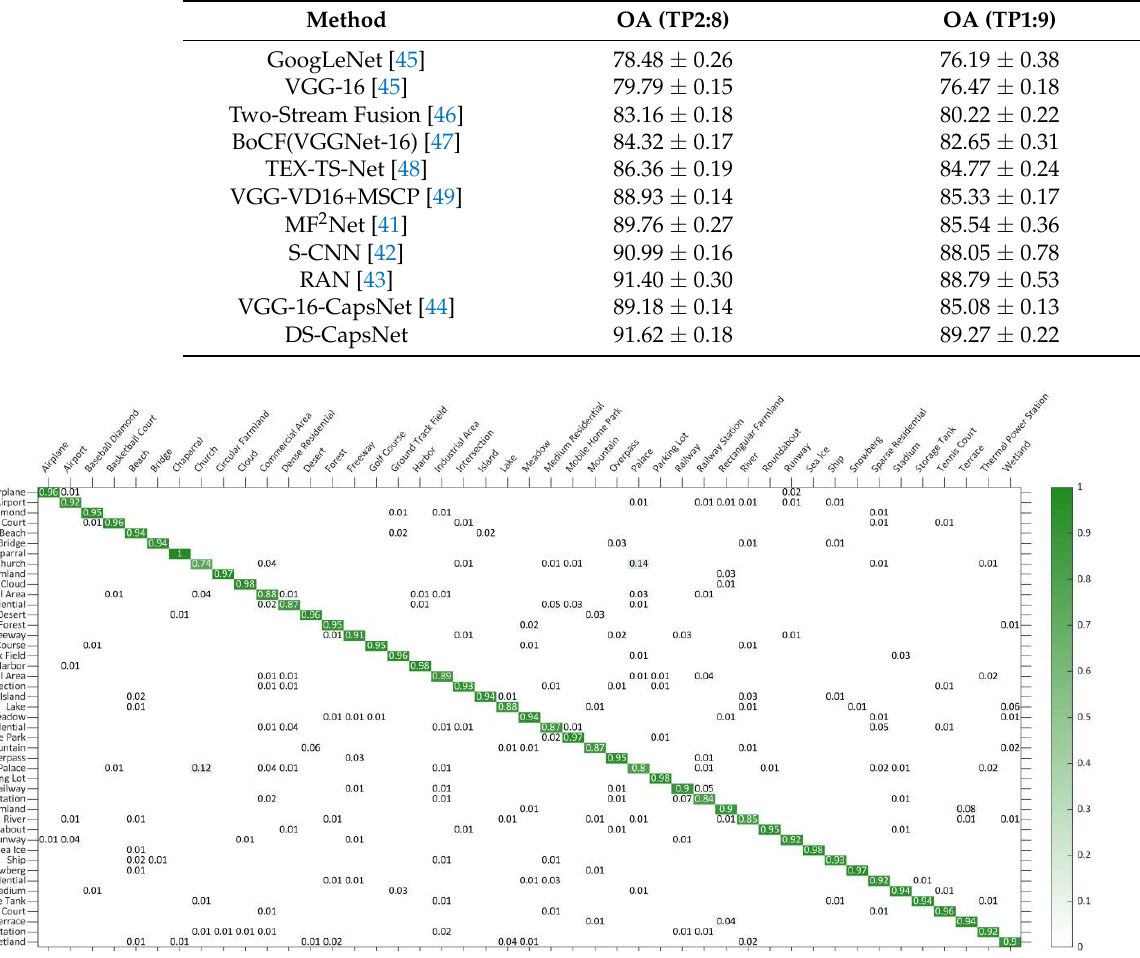
Table 4. Ablation test results of the proposed